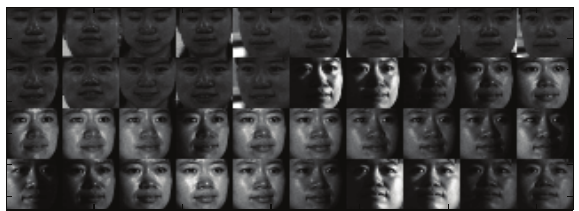
Figure 2: Samples from the CMU PIE database.